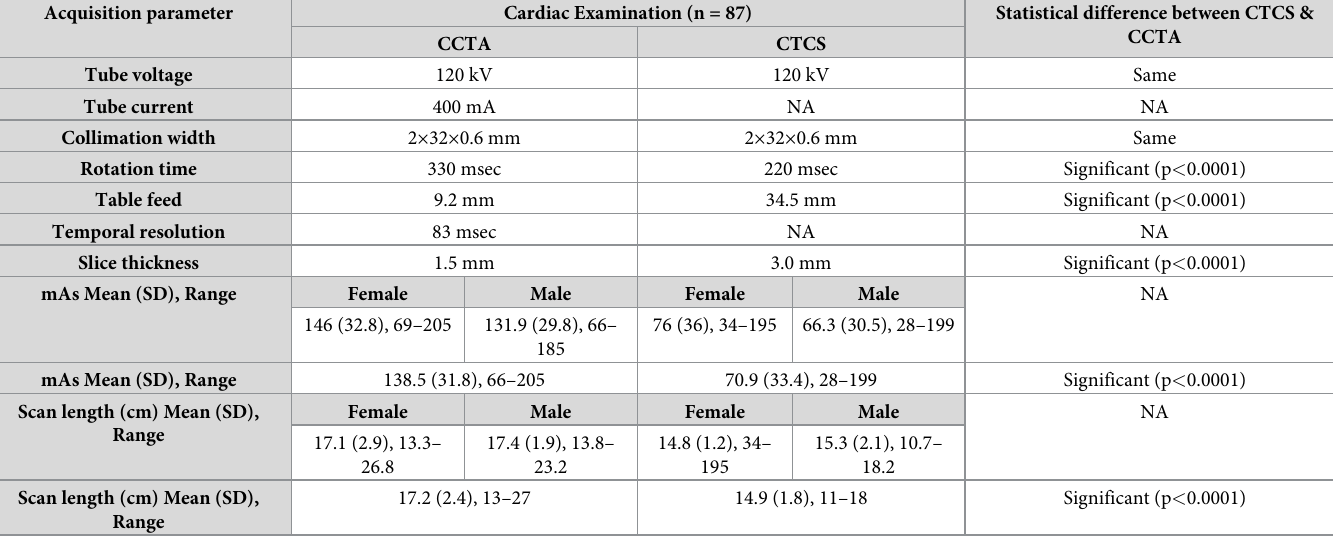
Table 2. Summary of CCTA and CTCS scan details and Acquisition Parameters (mAs and scan